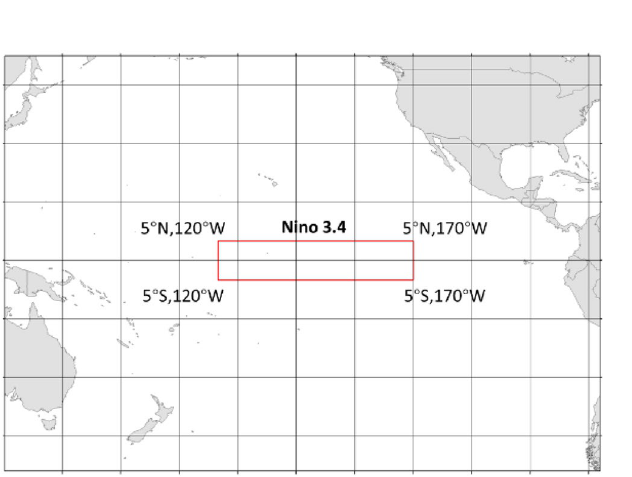
Figure 9. The Nino 3.4